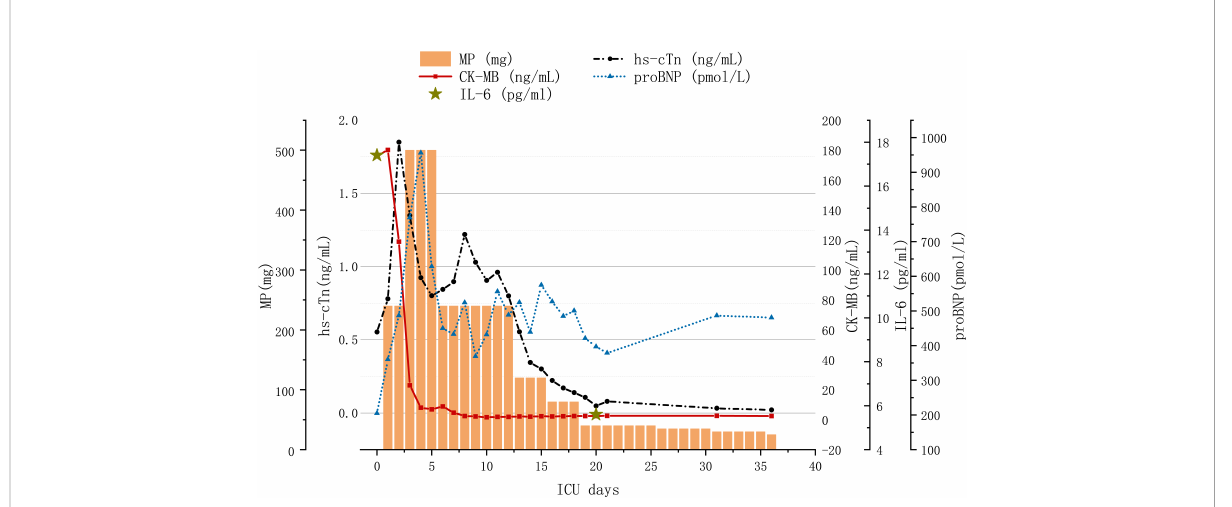
FIGURE 1 Variation in lab tests and treatment strategy with immune-related myocarditis. MP, methylprednisolone; hs-cTN, high-sensitivity cardiac troponin; CK-MB, creatine kinase MB Form; proBNP, pro-brain natriuretic peptide; IL-6, interleukin-6; IVIG, intravenous